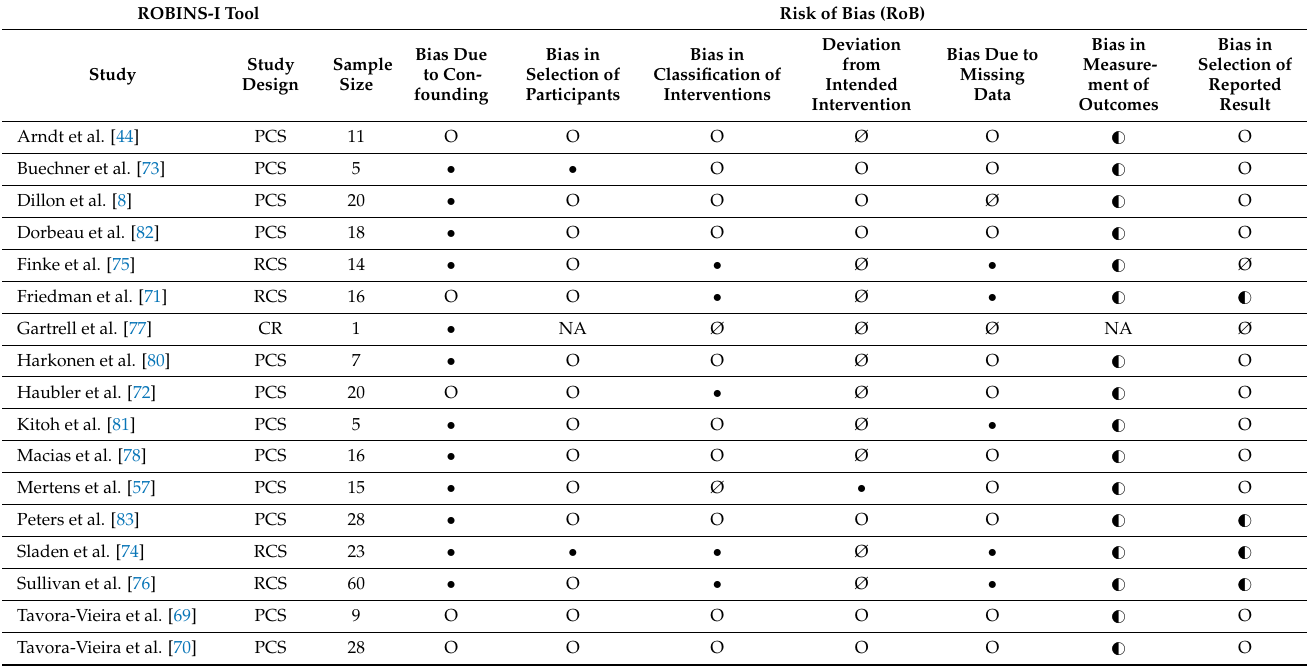
Table 2. Quality assessment of studies in which tinnitus was not the primary